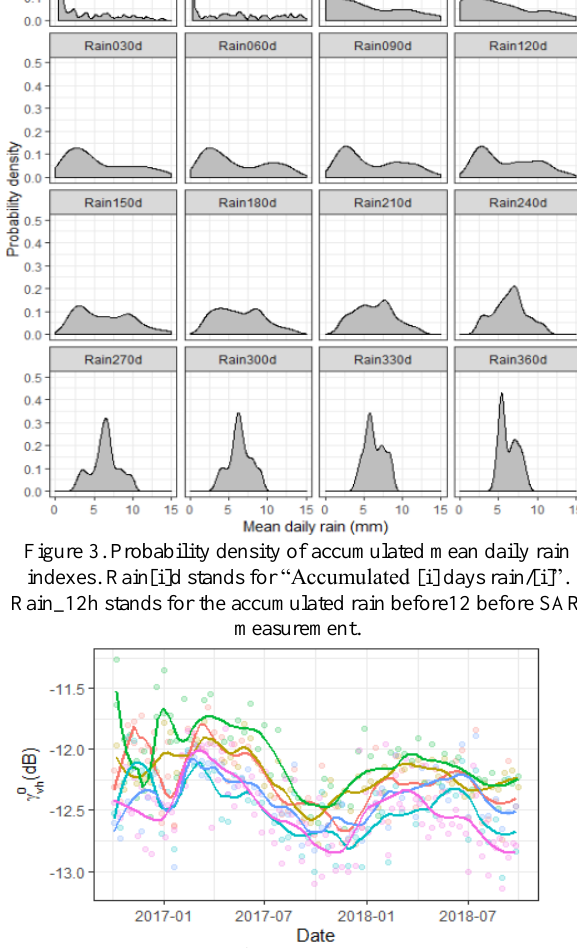
Figure 4. Periodicity of the mean SAR VH backscattering signal, of the selected forests areas. Every colour represents a different forest area (see Figure 1 and Figure 4 for area colors).